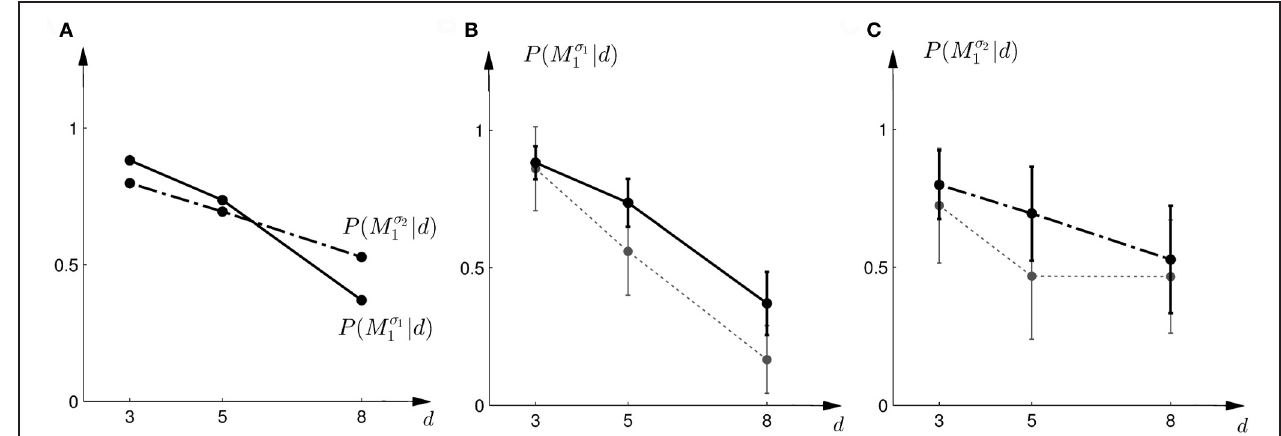
FIGURE 14 | Predictions and data: “halfway shift”-heuristic. (A) Shows the predicted choice probabilities for choosing M 1 , assuming that subjects base their decision on a shift equal to half of the largest value that lies within the array of width d . The predictions are based on response functions that have been fitted to the standard trial data. The solid line corresponds to the predicted choice probabilities for the first part of the study, the dash-dot line shows the predicted choice probabilities for the second part of the study, where the variance of M 1 was increased. Since the response functions have been fitted